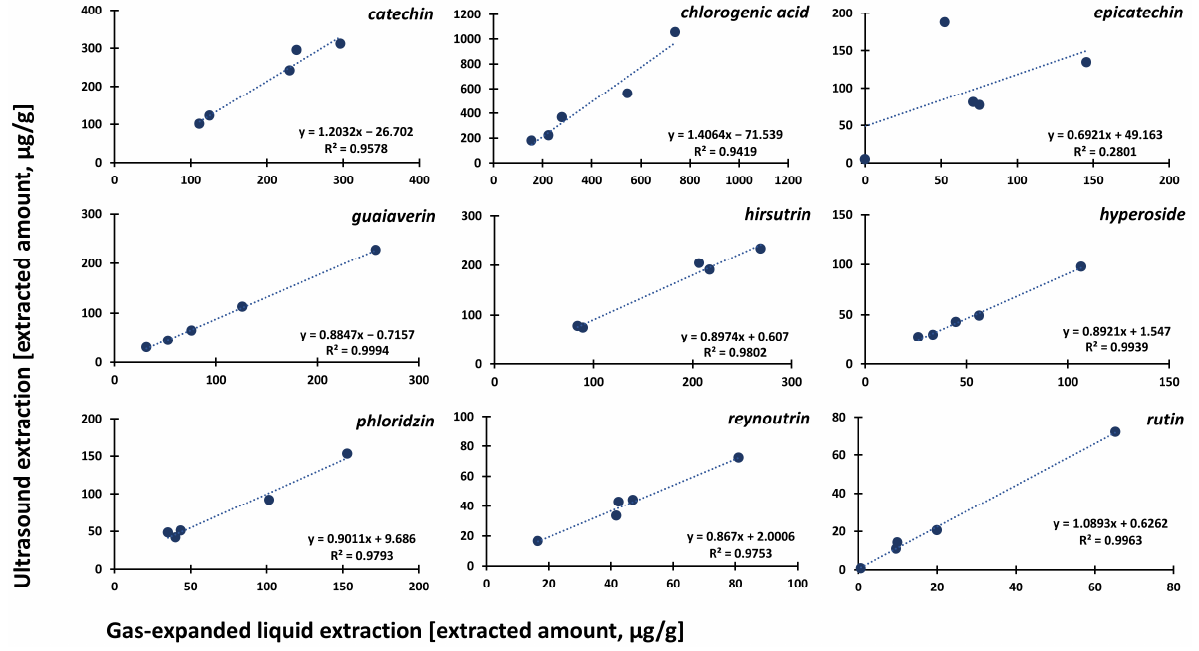
Figure 3. Correlation of extracted amounts for individual compounds from dried apples using GXLE and UE upon application of linear regression.